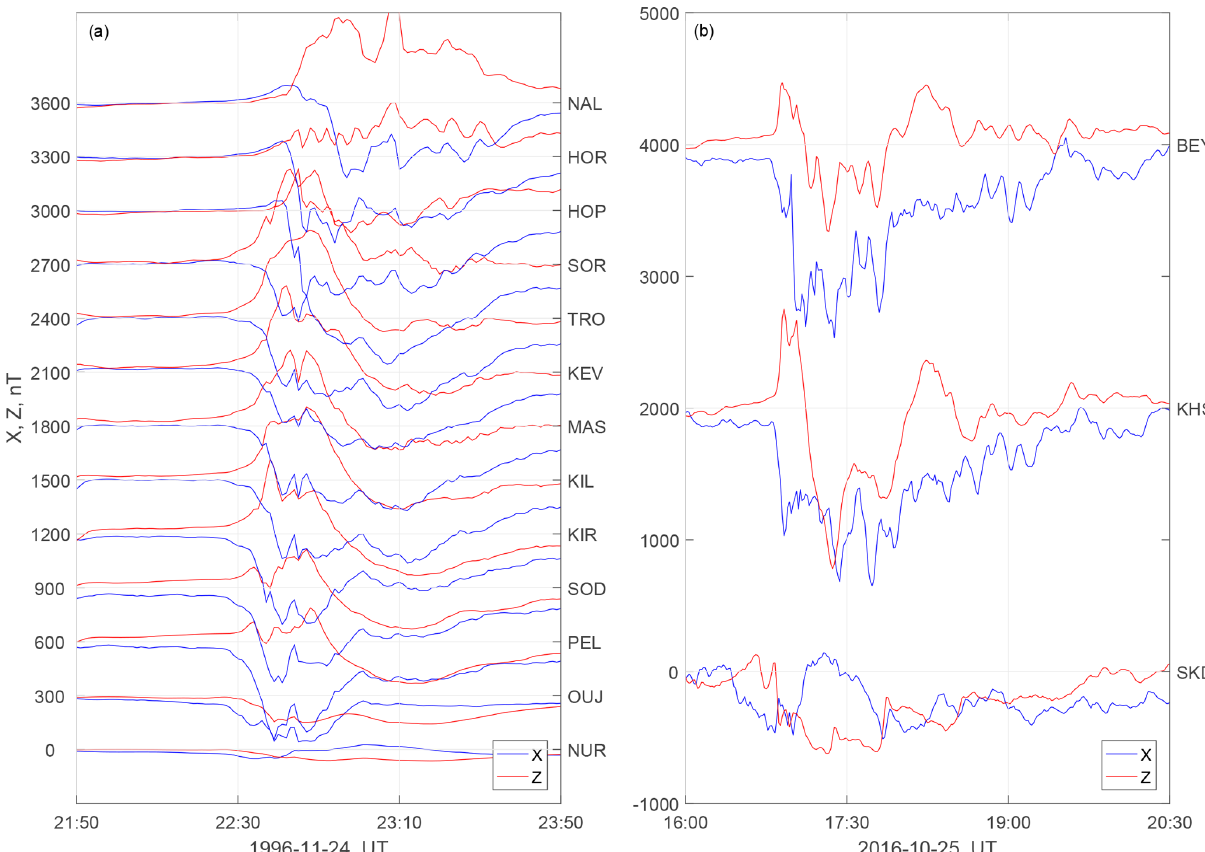
Figure 2. Examples of IMAGE (a) and Yamal (b)